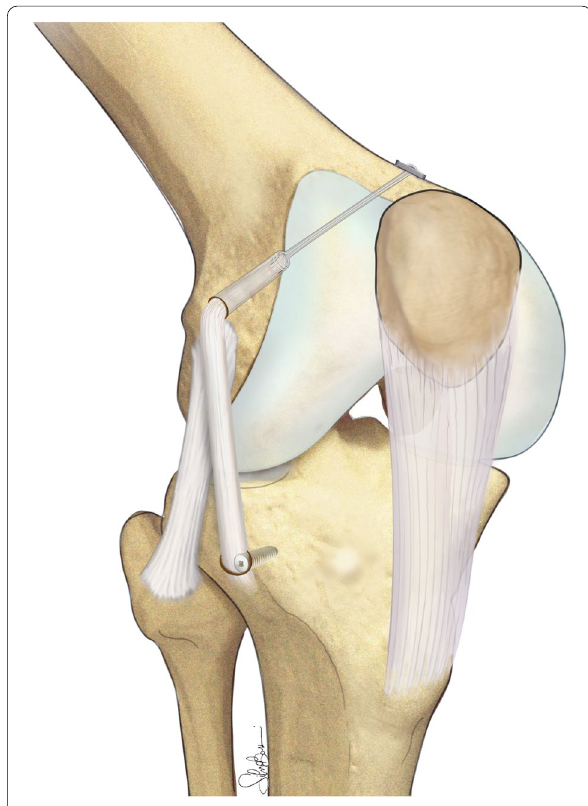
Fig. 3 Minimally invasive ALL reconstruction with gracilis tendon. The graft is fixed at the tibial insertion with a Bio-tenodesis screw, successively passed under the fascia lata, and locked into the femoral tunnel with an adjustable cortical fixation